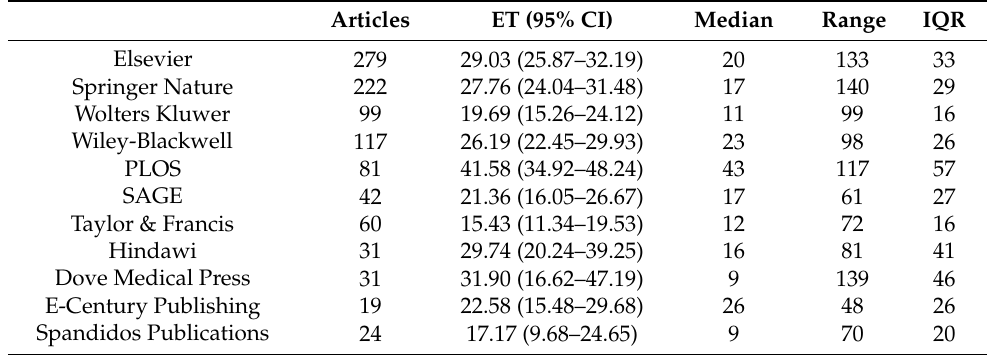
Table 5. Mistakes/Inconsistent data per